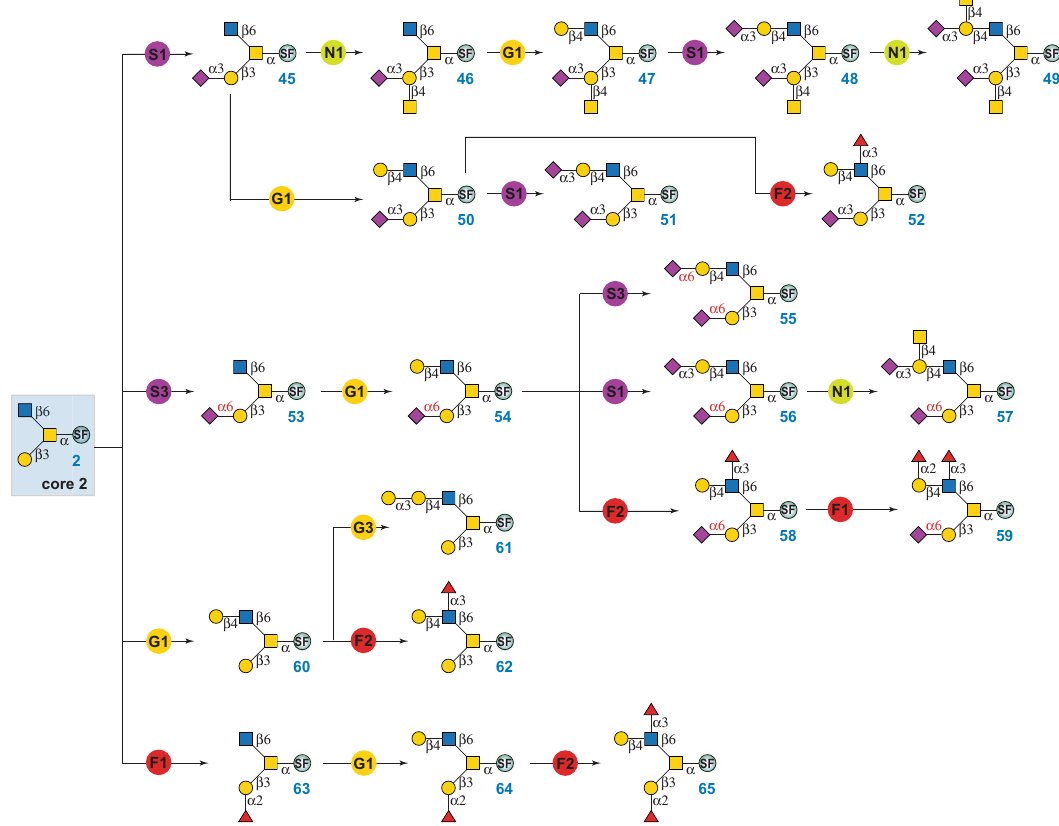
Fig. 5 Enzymatic modular synthesis of core 2 O-GalNAc glycans. G1: β 1-4 galactosylation with NmLgtB and UDP-Gal; G3: α 1-3 galactosylation with B α 3GalT and UDP-Gal; S1: α 2-3 sialylation with PmST1-M144D, NmCSS, CTP, and Neu5Ac; S3: α 2-6 sialylation with Pd2,6ST, NmCSS, CTP, and Neu5Ac; N1: β 1-4 N -acetylgalactosaminylation with CjCgtA and UDP-GalNAc; F1: α 1-2 fucosylation with Hm2FT and GDP-Fuc; F2: α 1-3 fucosylation with Hp3FT and GDP-Fuc. SF, Fmoc protected